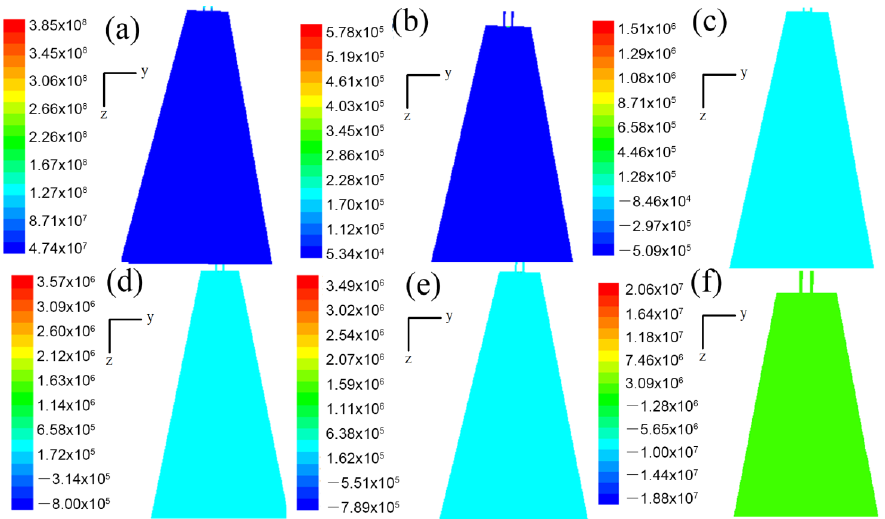
Figure 8. Pressure cloud distribution on the y–z plane (Pa): ( a ) velocity cloud distribution of flow field at time t = 1.000 × 10 − 7 s; ( b ) velocity cloud distribution of flow field at time t = 1.600 × 10 − 6 s; ( c ) velocity distribution of flow field at time t = 2.979 × 10 − 5 s; ( d ) velocity cloud distribution of flow field at time t = 1.338 × 10 − 4 s; ( e ) velocity cloud distribution of flow field at time t = 6.013 × 10 − 3 s; ( f ) velocity cloud distribution of flow field at time t = 1.543 × 10 − 2 s. 3.2. Variation of the Flow Field in the Area of the Spinning Line Figures 9 and 10 show the speed and pressure values on the spinning line at different times. Because the unsteady flow field was calculated in this work, the obtained velocity distributions and pressure distributions on the spinning line were constantly changing with time.